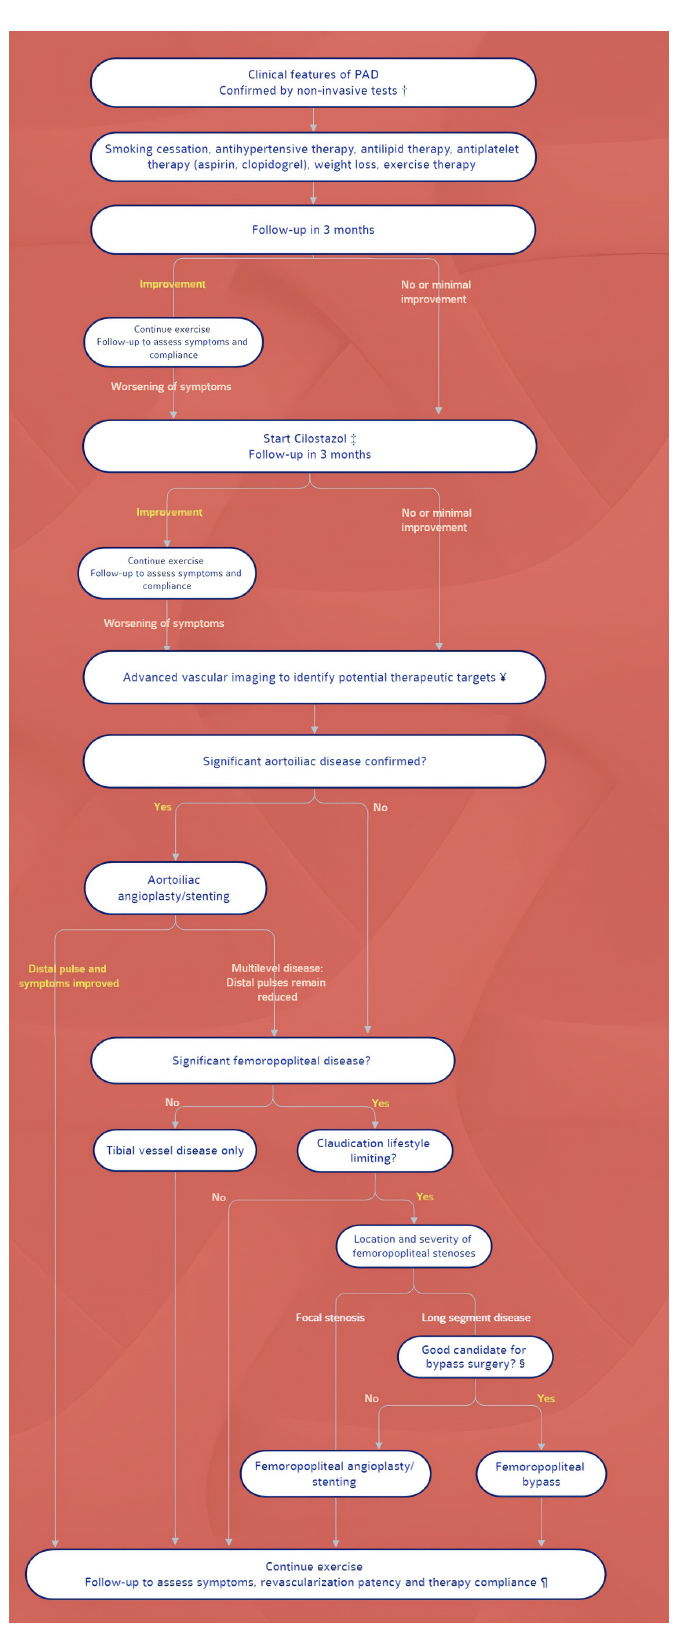
Figure 2. Algorithm for the management of PAD. Symbols: † Noninvasive studies include ankle- brachial pressure index, pulse volume recordings, partitioned pressures, and exercise